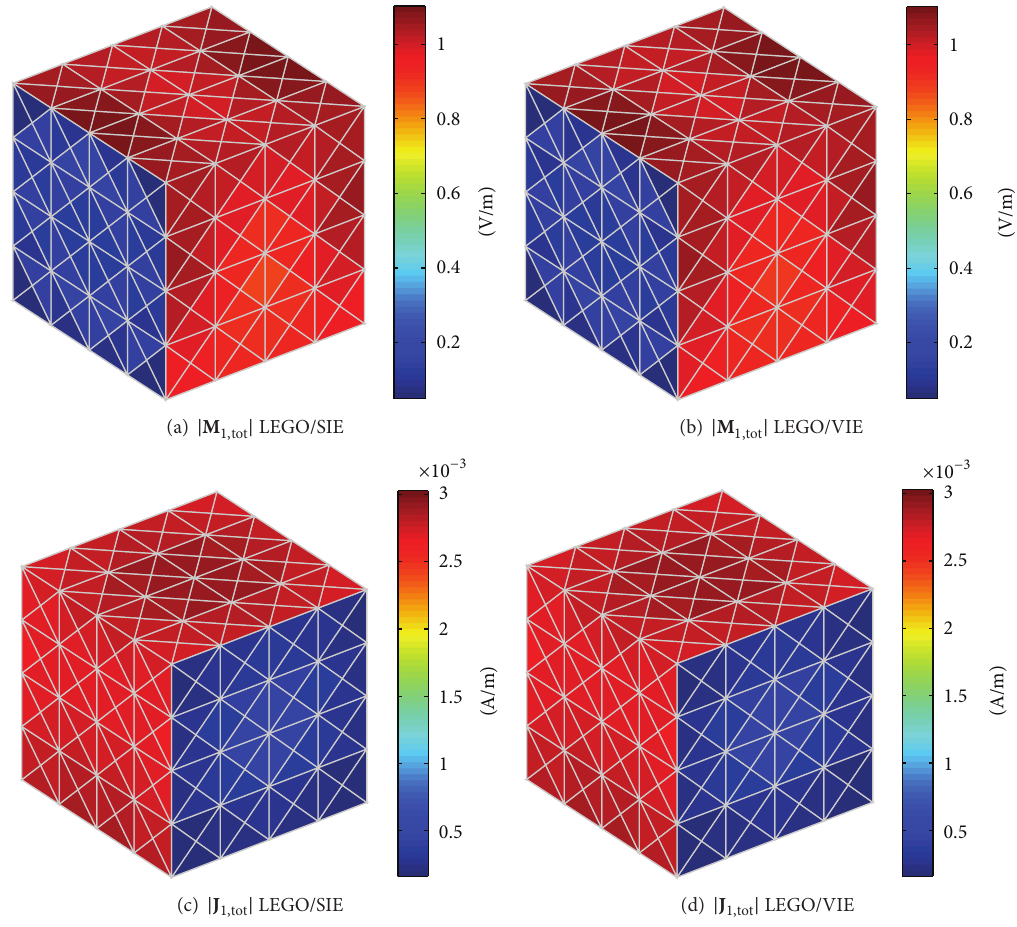
Figure 3: Example of validation in near field: total equivalent current densities M 𝑖 1, (not shown) in free space; (a), (c) results obtained with LEGO and PMCHWT; (b), (d) results obtained with LEGO and VIE (4). (See insets in Figure 4 for the surface and volumetric meshes of the sphere.) Data : brick’s edge 10cm, sphere’s radius 4cm, 𝜀 1 = 𝜀 2 = 𝜀 0 , 𝜀 3 = 2𝜀 0 I , ) V/m, and 𝑓 = 1 E 𝑖 = ̂ x exp (−𝑗2𝜋𝑓𝑧/𝑐 0